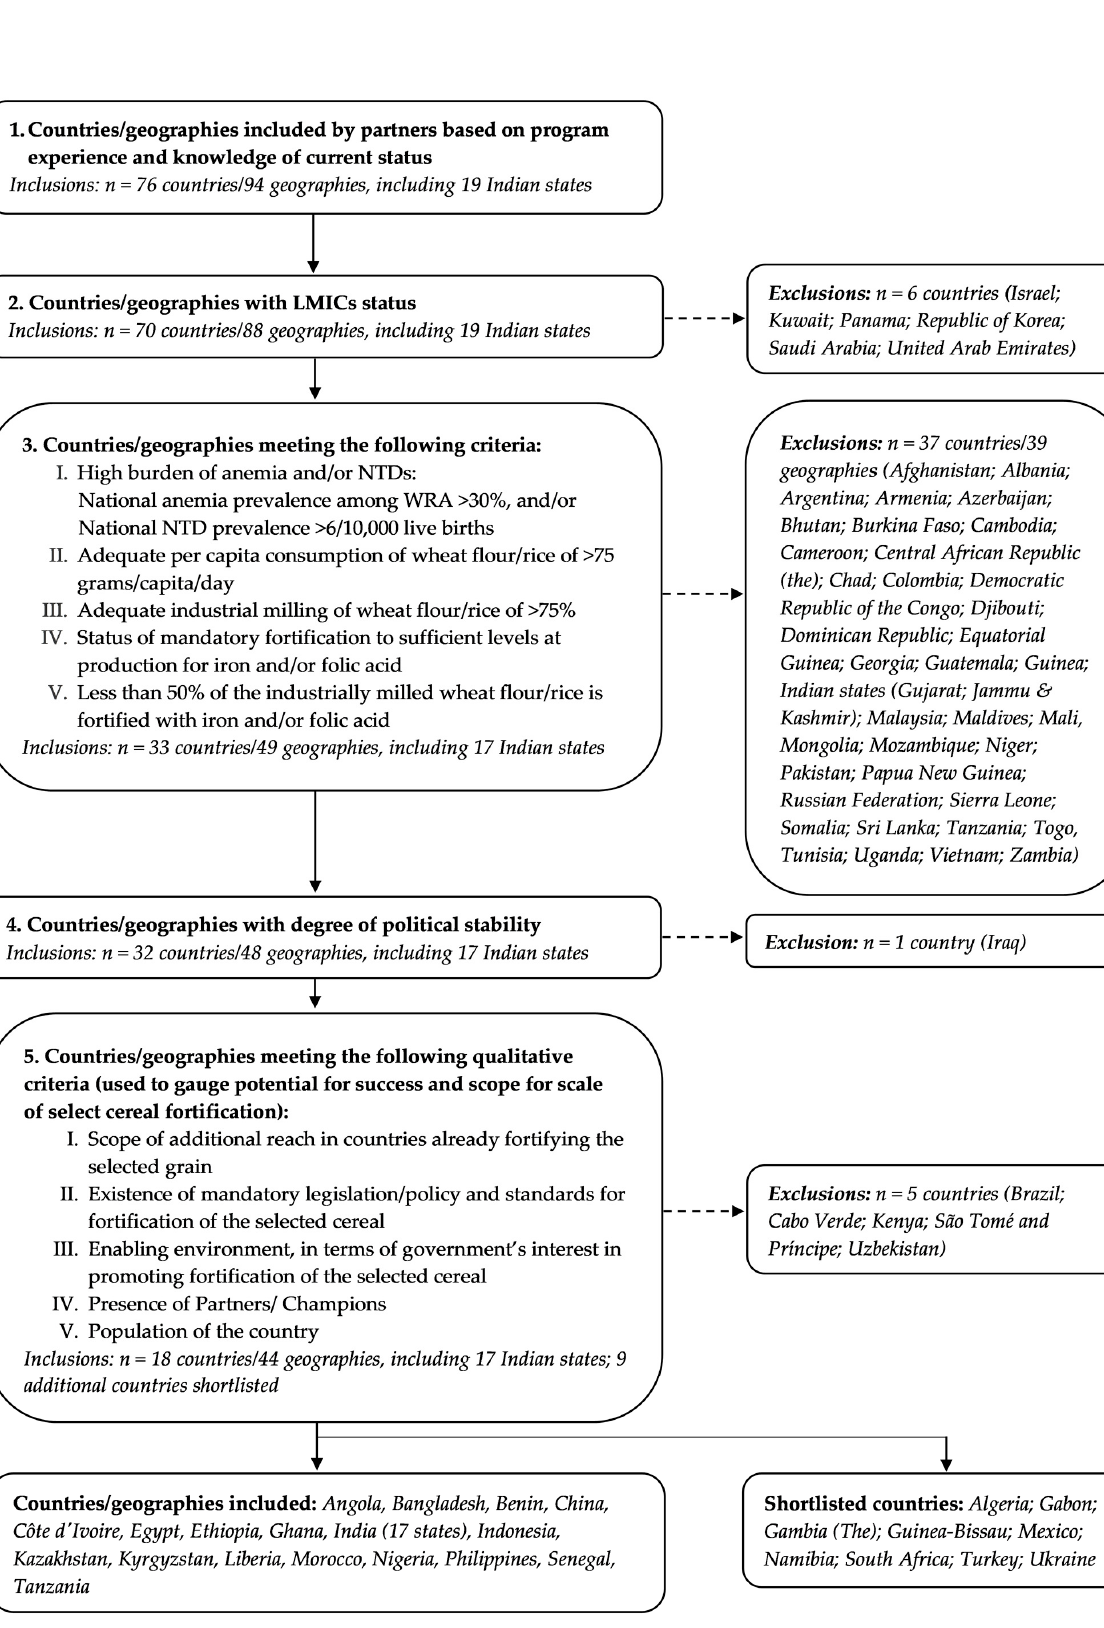
Figure 1. Flow diagram shows selection process to identify eligible countries with high impact potential for large-scale food fortification of wheat flour or rice.